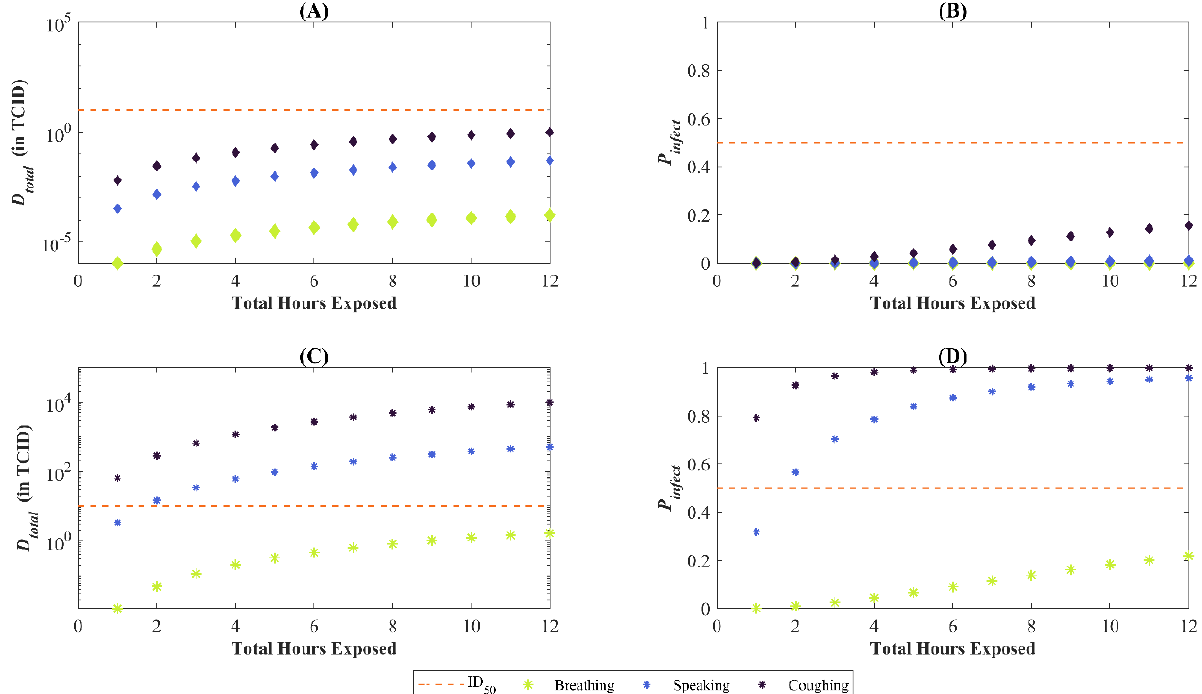
Figure 8 . Total deposited dose ( 𝐷 𝑡𝑜𝑡𝑎𝑙 ) and probability of infection ( 𝑃 𝑖𝑛𝑓𝑒𝑐𝑡 ) for varying continuous exposure periods. The orange dashed line in each subplot represents the ID 50 or 50% chance infection. Subplots ( A , B ) correspond to the median values, whereas ( C , D ) to the 95th percentile. In our baseline scenario, this is only met for the 95th percentile of 𝐷 𝑡𝑜𝑡𝑎𝑙 (or 𝑃 𝑖𝑛𝑓𝑒𝑐𝑡 ) and if coughing or speaking is the particle emission mechanism into the environment by the infectious person.